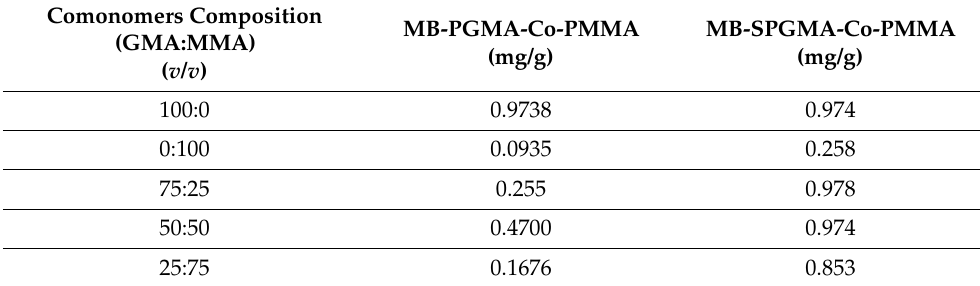
Table 2. The composition of both MB-PGMA-co-PMMA and MB-SPGMA-co-PMMA composites.